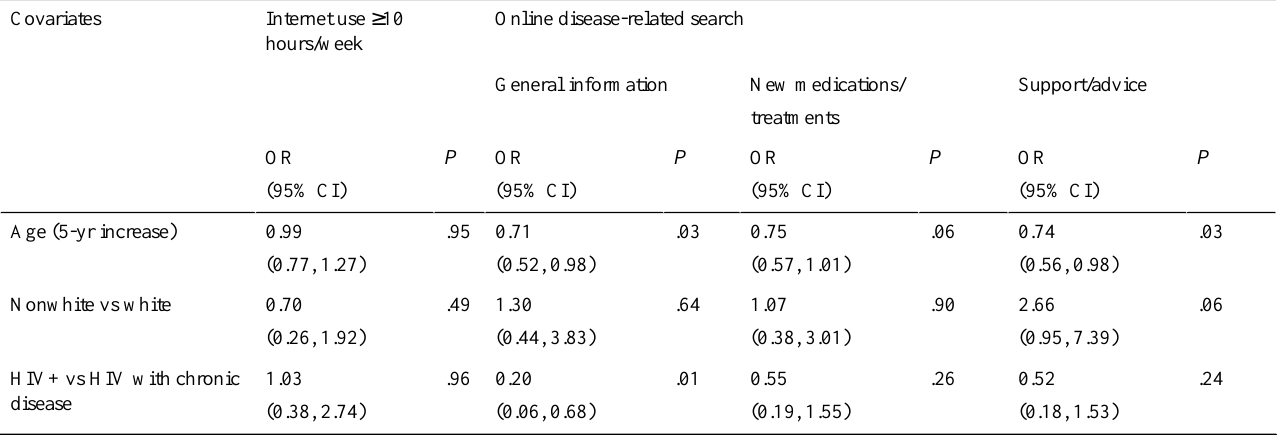
Table 3. Analysis results of multiple logistic